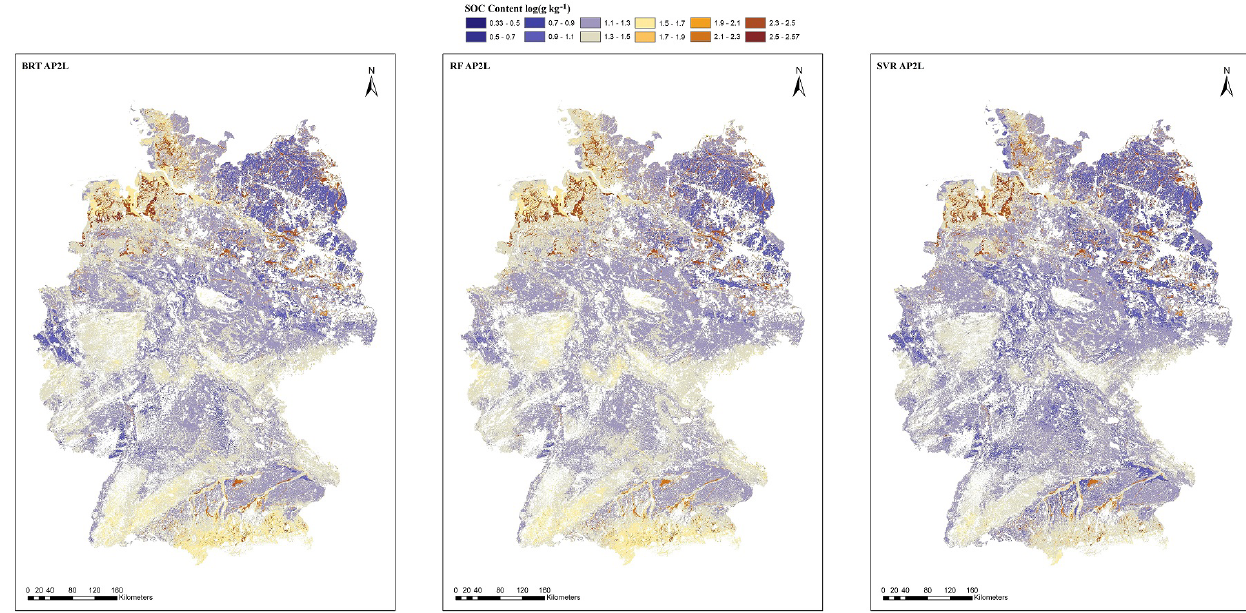
Figure 7. Spatial prediction of the SOC content (gkg − 1 ) of German agricultural soils based on the two-model approach for the three algorithms (BRT AP2L, RF AP2L, and SVR AP2L). The abbreviations used in the figure are as follows: BRT – boosted regression trees, RF – random forest, and SVR – support vector regression. It is important to note that the provided spatial prediction of the SOC content must not be used to identify the organic soils of Germany nor to determine their spatial